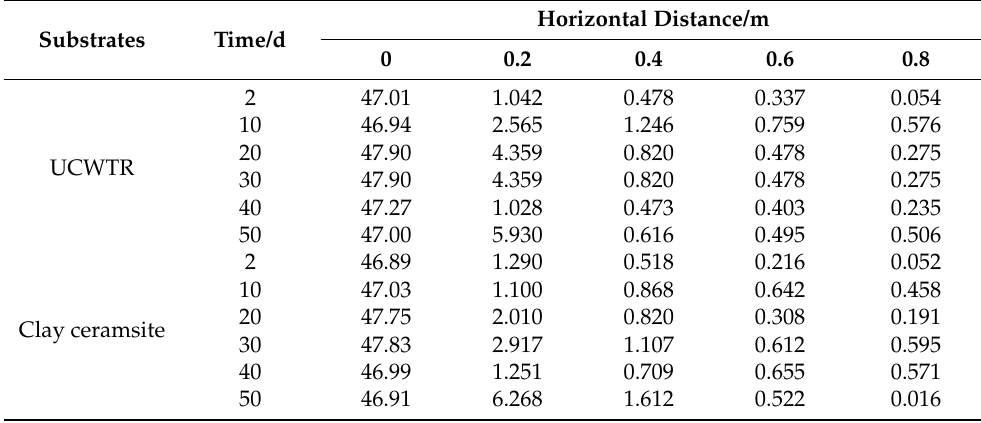
Table 6. Change in horizontal Zn concentration at 2 d, 10 d, 20 d, 30 d, 40 d, 50 d